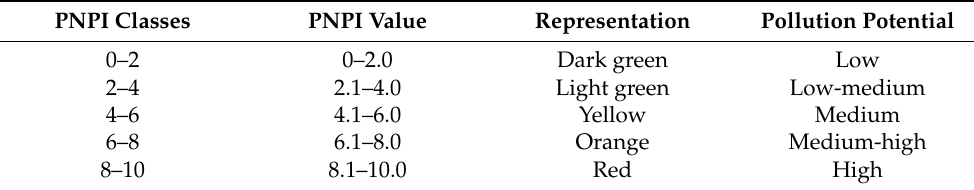
Table 4. Categorisation of potential non-point pollution index (PNPI) classes from value